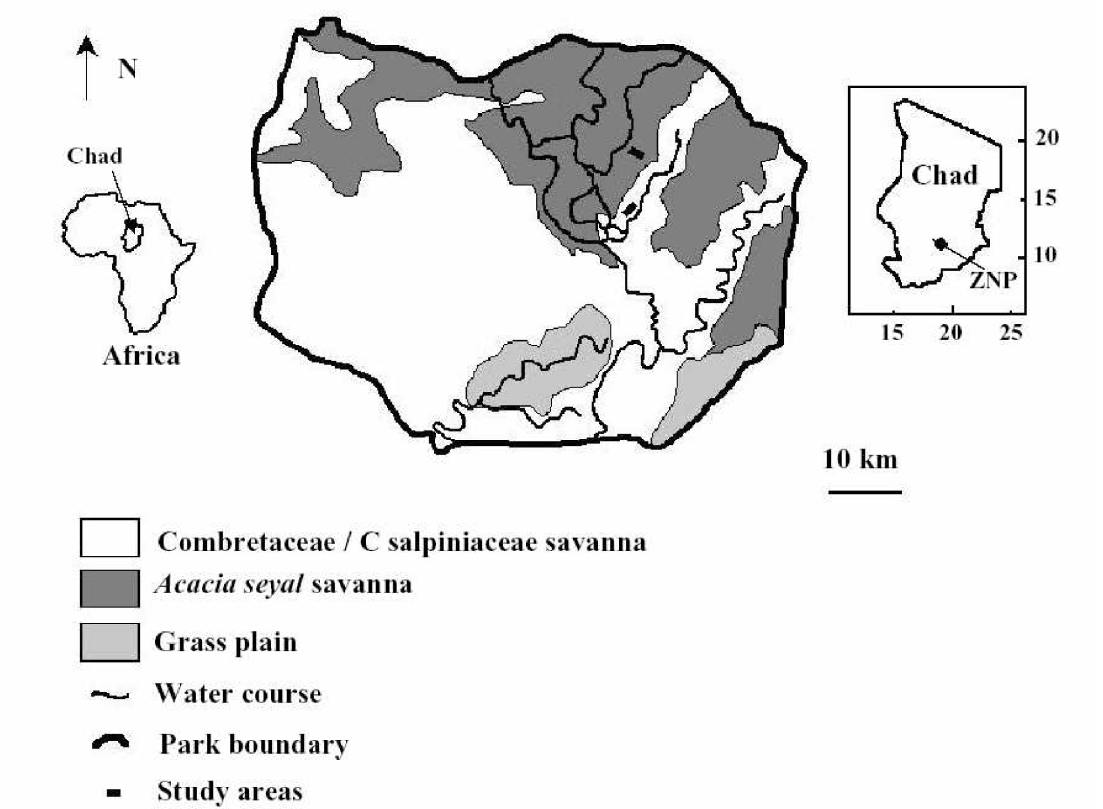
Fig 2. Map of Zakouma National Park, Chad (redrawn from Calenge et al.